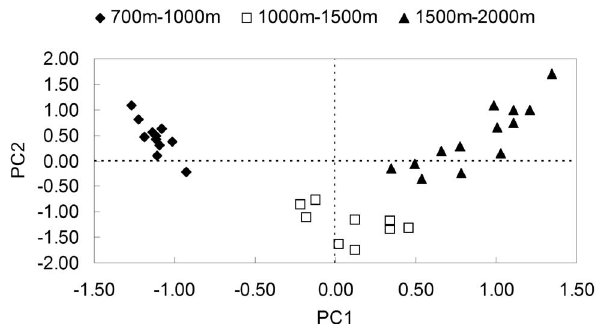
Figure 1. PCA ordination plot based on vegetation composi- tion showing three distinct clusters (proportion variance explained for PC1=24% and for PC2=11%; eigenvalues for PC1=4.83 and PC2=2.12).